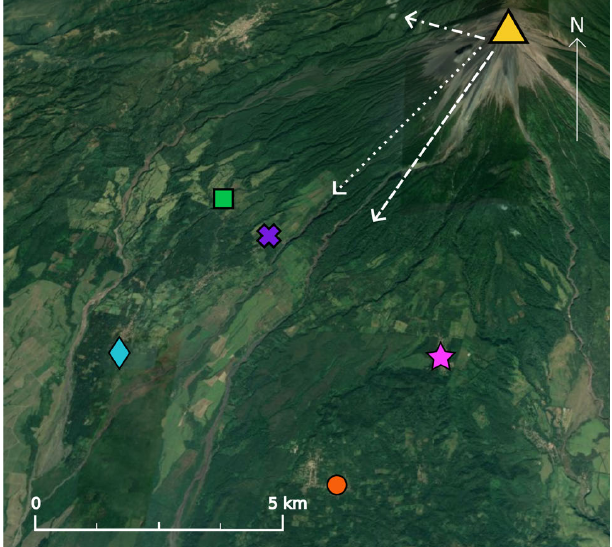
Figure 4: Local descriptions of tephra fall from the 1974 eruption. Symbols describe local communi- ties: pink star (Ceilán), blue diamond (Los Yucales), green square (Panimaché Dos), purple cross (Pani- maché Uno), orange circle (San Andres Osuna). Large yellow circle is summit of Fuego. Arrows represent wind directions of the October 14 th 1974 eruption and show predominant wind direction towards WSW. Lines represent altitudes: dashed (4000 m altitude at 215°), dashed (10000 m at 225°), dot-dash (7000 m at 285°). Wind directions from Figure 4 of Rose et al. [2008]. Lo- cals’ verbatim descriptions of tephra fall are found in Table 3. Map data: Google Earth [2020]. preserve